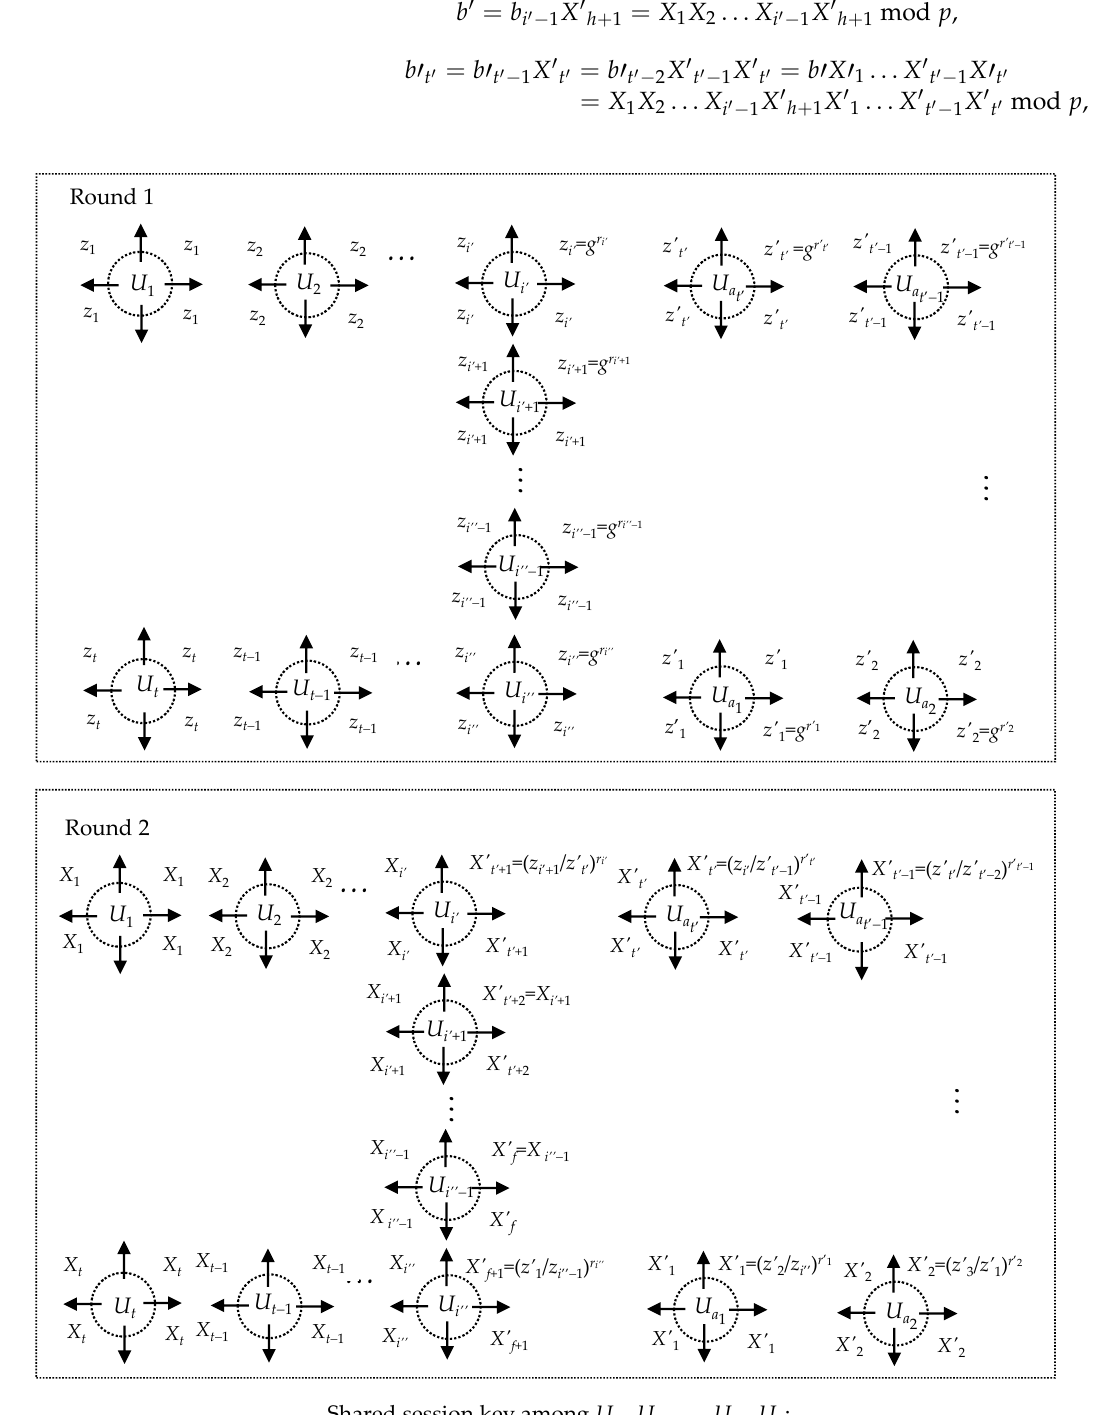
Figure 3. Member tampering attack on the broadcast protocol.